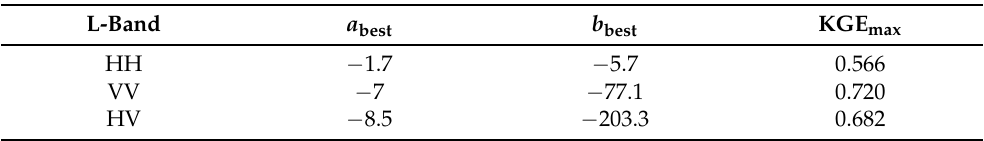
Figure 8. Simulated versus observed field average bare soil SAR bistatic scattering in XTI flight configuration for HH ( left ) and VV ( right ) polarization. Bistatic scattering simulations are performed with the physically-based AIEM and in situ measured roughness parameters. Table 3. Regression model parameters for estimating the effective l -values for the AIEM from normalized backscatter observations, whereby s is set at 1.75